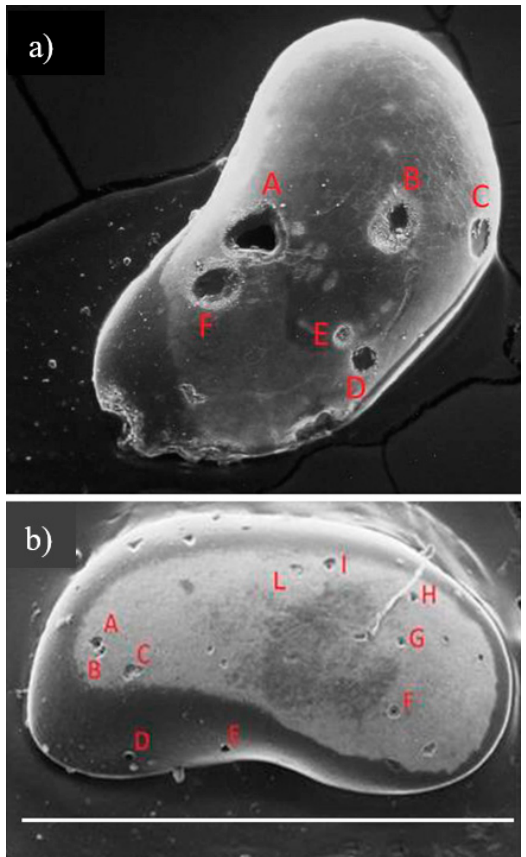
Figure 8. Examples of specimens with multiple perforations. ( a ) Caspiocypris basilicii , female right valve in external view, with evident abrasions along the anterior margin. Scale bar = 1 mm. ( b ) Caspiocypris tiberina , female right valve, external view. Scale bar = 1 mm. Red letters indicate the holes measured. The female right valves (45) are numerically more common, while the male right valves (2) are